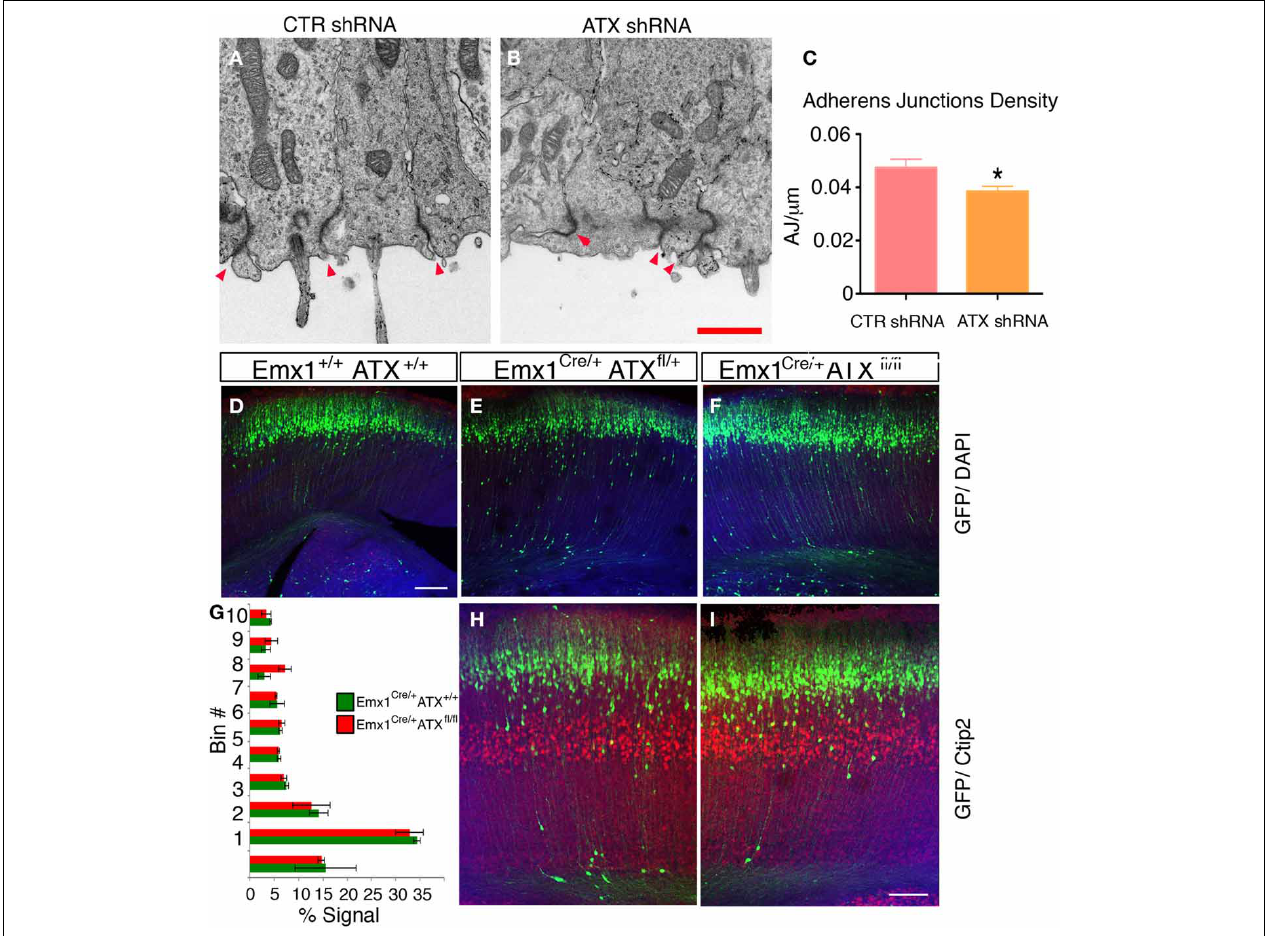
∗ p < 0 . 05. (D–I) ATX Knock out embryos do not display a neuronal migration phenotype. (D–F) littermates of indicated genotypes were electroporated in utero at E14 with GFP expressing plasmid and analyzed 4 days later. The location of the GFP + cells did not differ in WT (D) heterozygous (E) or ATX knockout embryos (F,G) The distribution of GFP + cells along 10 arbitrary bins spanning the width of the cortex in mutant (Red) and WT (green) embryos are presented. The shown results are averaged from 3 to 4 brains. (H,I) Deeper layers neurons (Ctip2 + , layer V) are normally layered in WT (G) and